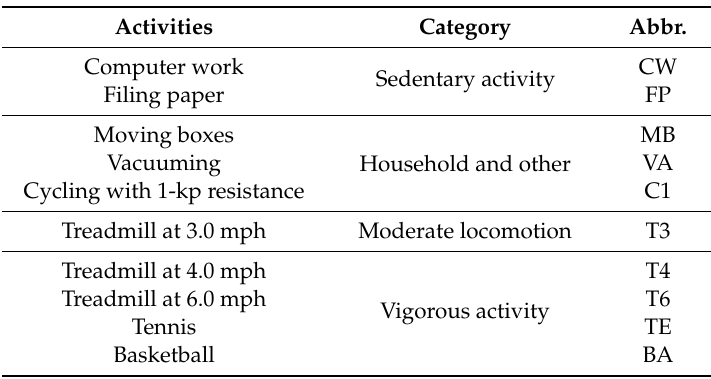
Table 2. Physical activity types for